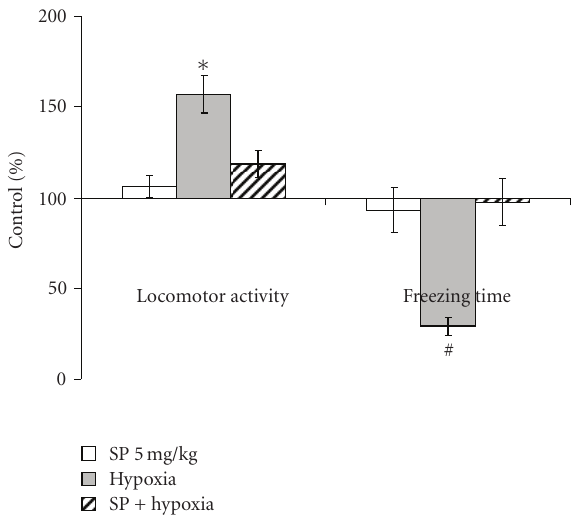
Figure 5: Influence of the pre-treatment with 5mg/kg SP on the behavioral e ff ects of the acute hypobaric hypoxia of pregnant rats with low resistance to hypoxia in the open field test 24 hours after hypoxia. Statistical significance: ∗ P < . 05; # P ≤ . 1 .